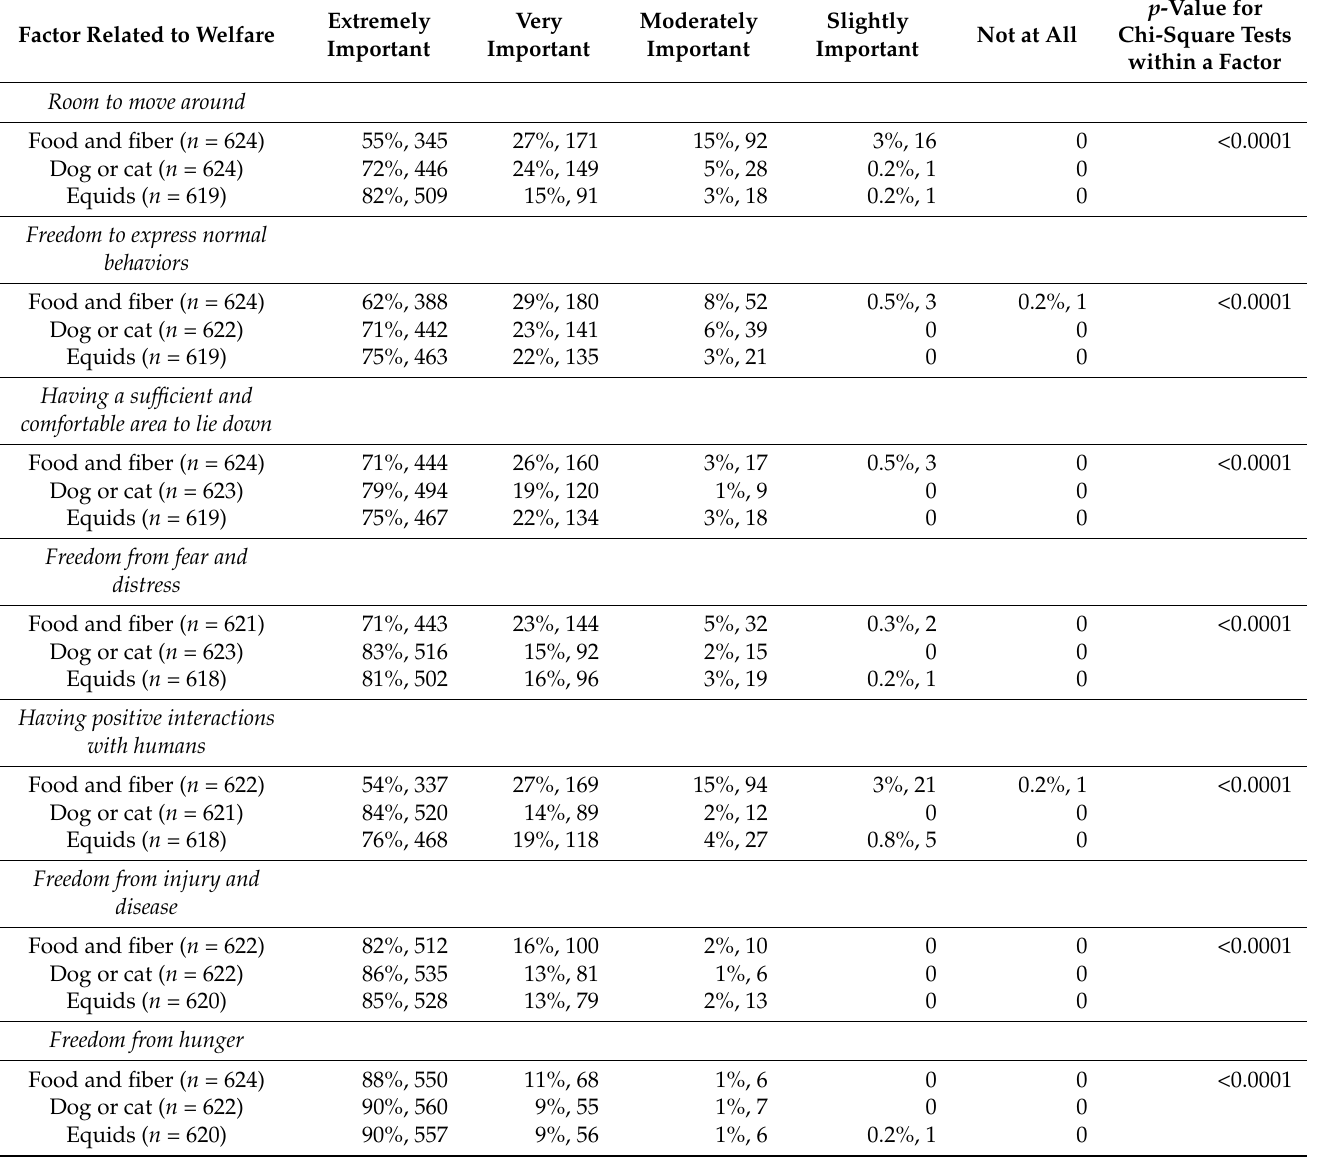
Table 2. The percentage of respondents for each level of importance when asked “what is your assessment of the importance of each of these parameters for” three different animal categories (i.e., food and fiber animals, dogs and cats, and equids) for 12 factors related to animal welfare. A chi-square test was performed for each species within a factor related to welfare; one p -value for each factor is shown for clarity. χ 2 between 224 and 1566 (df between 2 and 4; n between 608 and